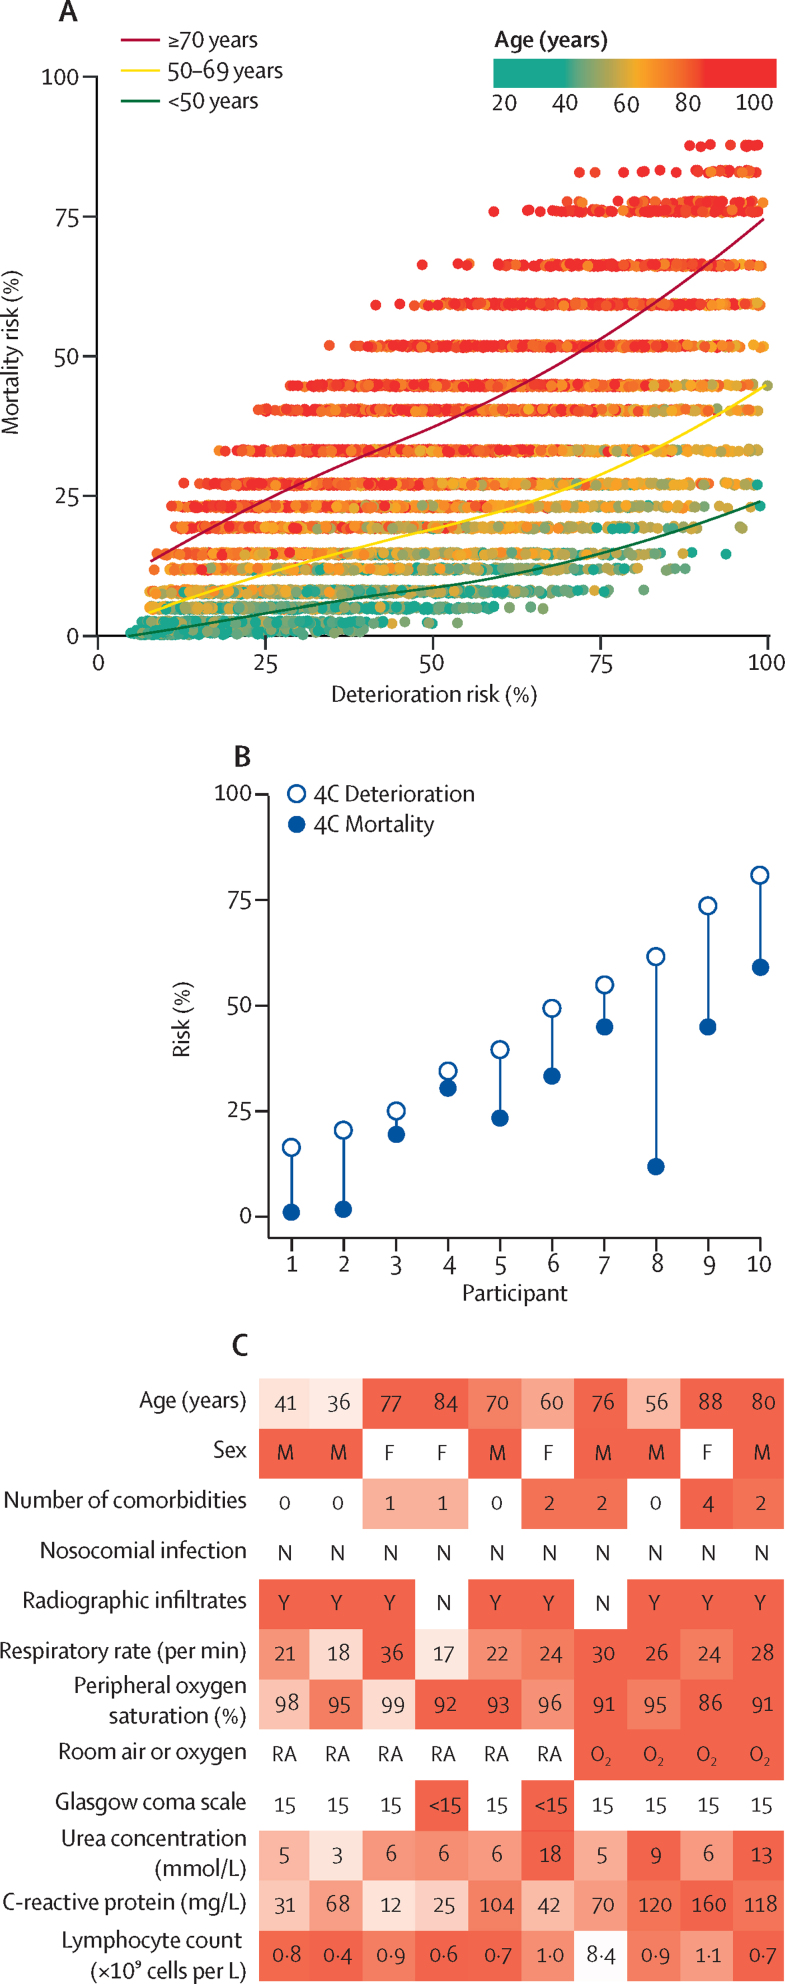
4C Deterioration versus 4C Mortality predictions for London validation cohort (n=8239) and randomly sampled example patients (n=10)4C Mortality probabilities are calculated from points scores, based on observed mortality risk for each score in the original validation data. (A) Smoothed plot reflects locally estimated scatterplot smoothing fit, stratified by age (<50 years, 50–69 years, or ≥70 years), in the London cohort (n=8239). (B) Ten example patients were randomly sampled from the validation cohort, stratified by deciles of 4C Deterioration model predictions. (C) Characteristics of each example participant, with red indicating characteristics associated with higher risk predictions. M=male. F=female. N=no. Y=yes. RA=breathing room air. O2=receiving oxygen therapy.